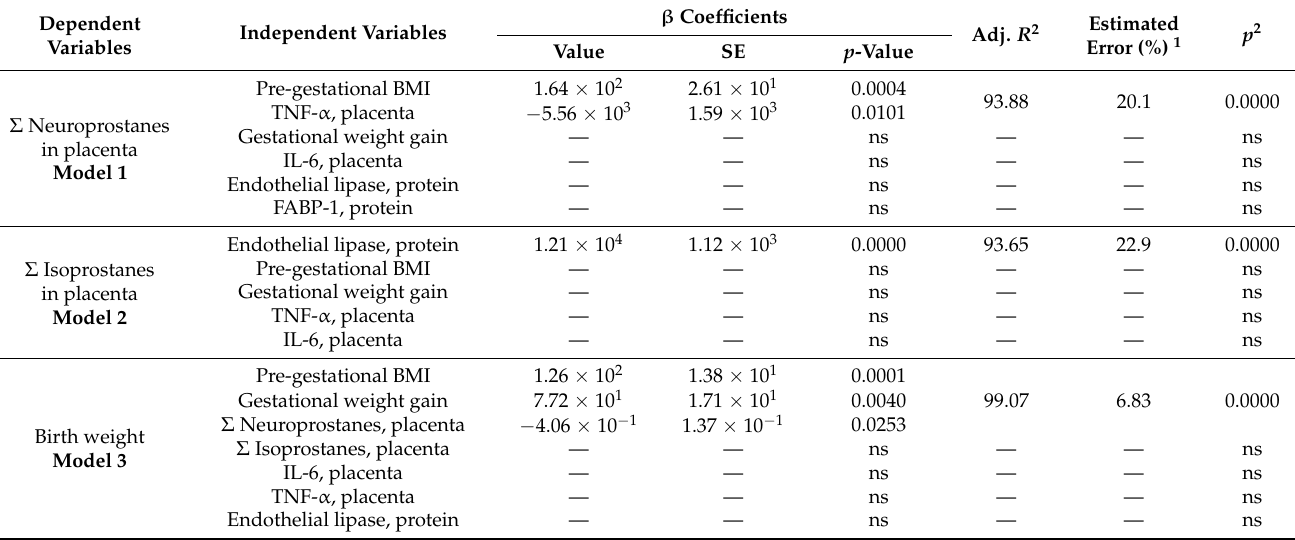
1 Estimated relative error of estimate = (estimated absolute error × 100%)/average value of the dependent variable; 2 Model significance. Significant associations were independent of the following variables, denoted as non-significant (ns) p -values: model 1, gestational weight gain, IL-6 (placenta), endothelial lipase protein (placenta), and FABP1 (placenta); model 2, pre-gestational BMI, gestational weight gain, TNF- α (placenta), and IL-6 (placenta); model 3, Σ of isoprostanes (placenta), interleukin-6 (placenta), TNF- α (placenta), and endothelial lipase protein (placenta);—blank cell; IL-6: Interleukin-6; TNF- α : Tumour Necrosis Factor- α